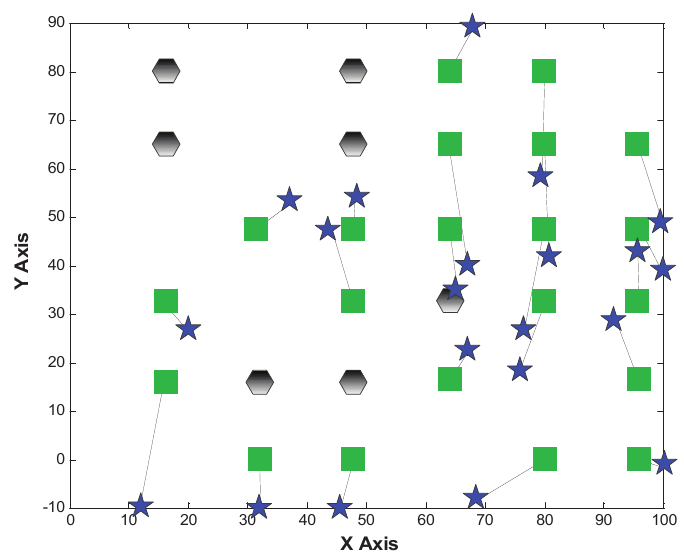
Figure 13. Localization results of MDS-SSLE.